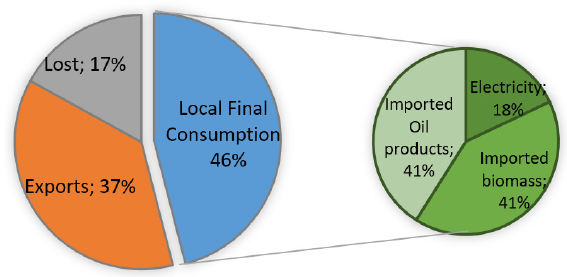
Figure 2. Paraguay’s Energy matrix 2016 [35].